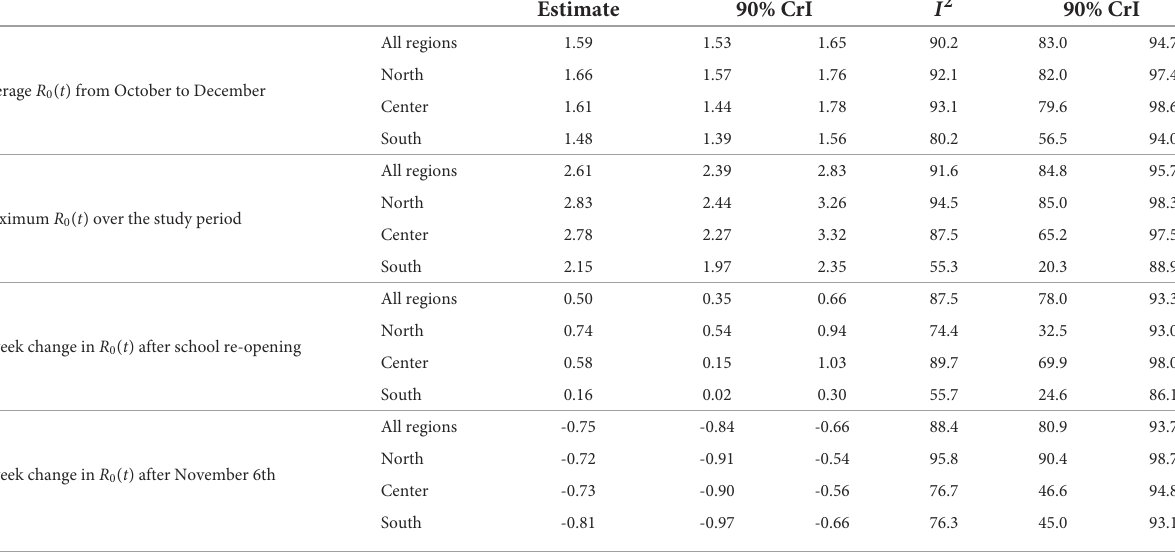
TABLE 1 Results of the Bayesian meta-analyses (posterior mean of the quantity of interest and posterior median of the I 2 index, with associated 90% credible intervals) conducted on: average value of R 0 ( t ) from October to December, maximum value of R 0 ( t ) over the study period, changes in R 0 ( t ) after school re-opening and after the introduction of national restrictions on November 6th; p = 1.15 % , T = 14